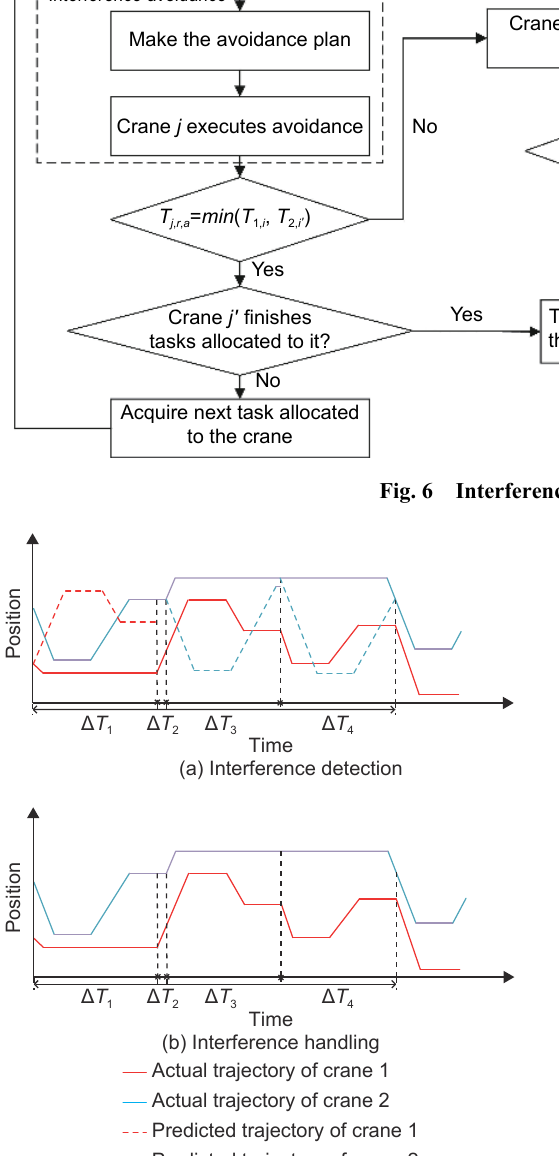
Fig. 7 Example to handle